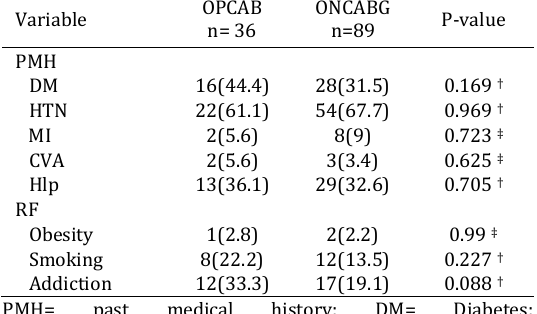
Table 1. Comparison of the past medical history and Risk Factors of patients between OPCAB and ONCAB group.